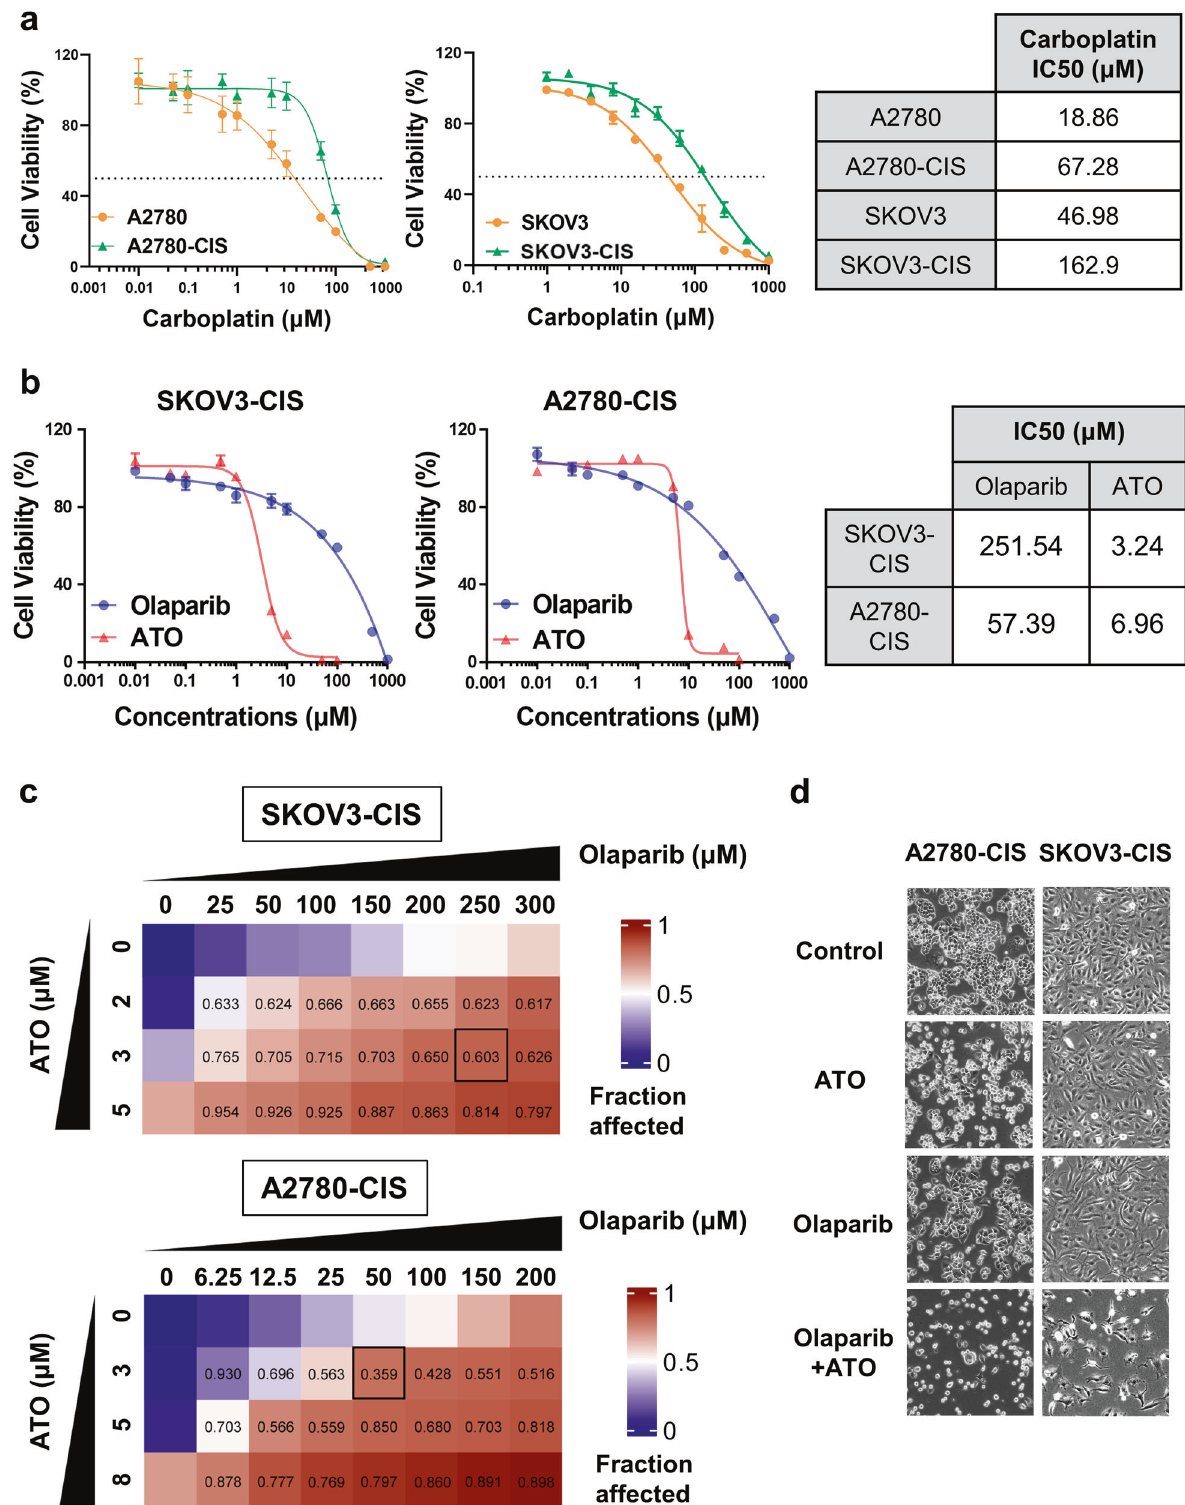
Fig. 1 ATO plus olaparib exerts synergistic cytotoxicity in platinum-resistant OC cells. a , b Drug-response curves of survival and IC 50 values for cell viability after a series of concentrations treatment of carboplatin ( a ), olaparib or ATO ( b ) in the ovarian cancer cell lines measured by CCK-8 assay at 72 h. c Representative synergy matrix heatmaps for olaparib and ATO treatment in SKOV3-CIS and A2780-CIS cells. Cells were exposed to the indicated concentrations of olaparib and ATO for 72 h and cell viabilities were assessed by a CCK-8 assay. The combination index (CI) values were determined by CompuSyn software and shown numerically inside the boxes of the heatmaps. CI values < 1 indicate synergistic effects. d After treatment with 250 μ M olaparib and 3 μ M ATO in SKOV3-CIS cells, 50 μ M olaparib and 3 μ M ATO in A2780-CIS cells for 48 h, the morphology alteration was observed using an inverted phase contrast microscope (Leica CTR6500). Error bars are represented as mean ± SD from three independent repeats. Cell Death and Disease (2022)